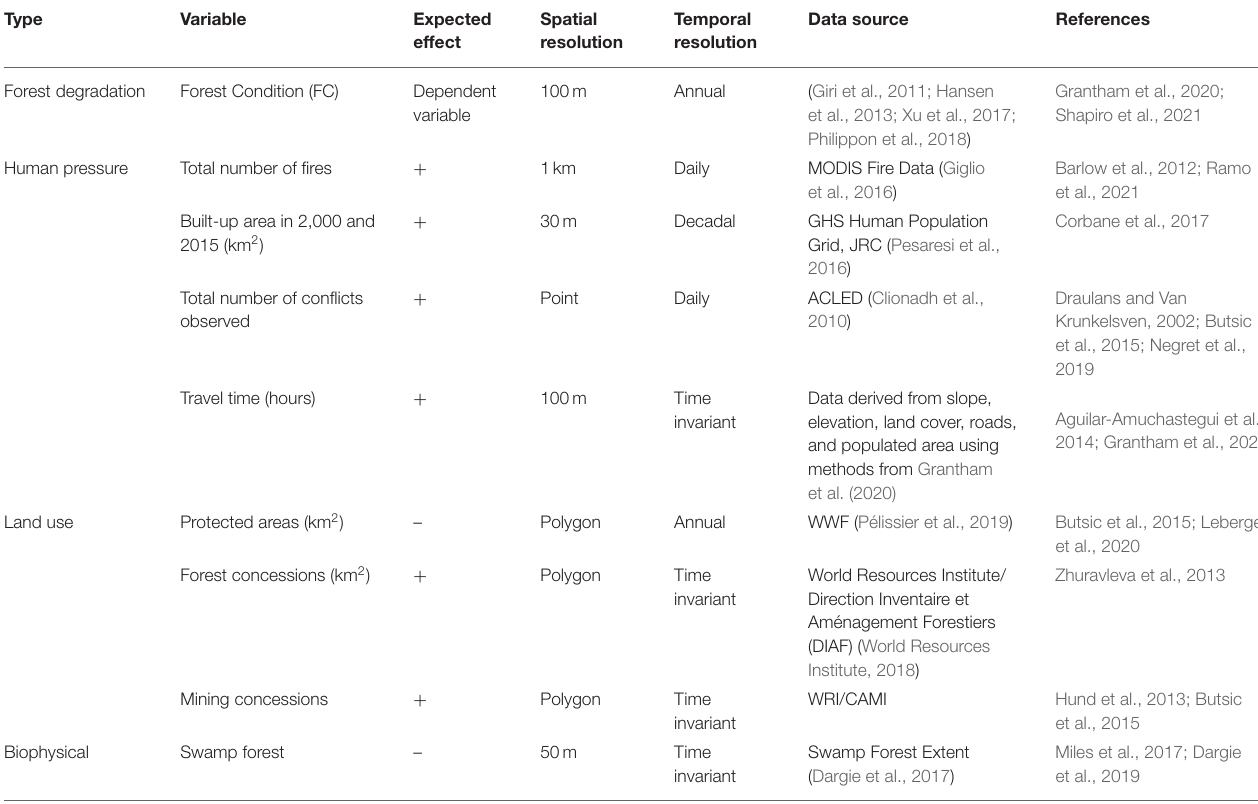
TABLE 1 | Variables evaluated for each forest grid and relevant